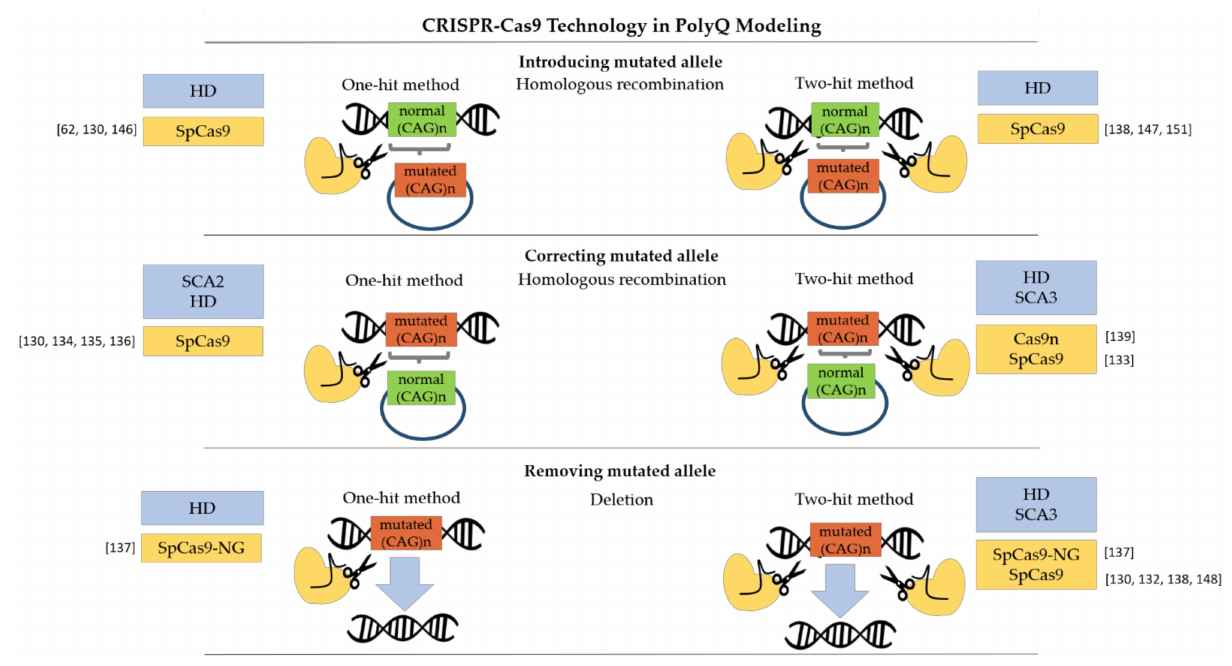
Figure 1. Overview of approaches to creating polyQ disease models with CRISPR-Cas9 genome-editing tool. CRISPR-Cas9 technology is used to introduce or repair a mutant allele by inducing homologous recombination (HR), as well as to excise a mutant DNA sequence. In either case, single-molecule (one-hit method) [62,130,134–137,146] or two-molecule (two-hit method) [130,132,133,137–139,147,148,151] gRNA may be used. The use of modified Streptococcus pyogenes Cas9 (SpCas9) nucleases further enhances the modeling possibilities of polyQ